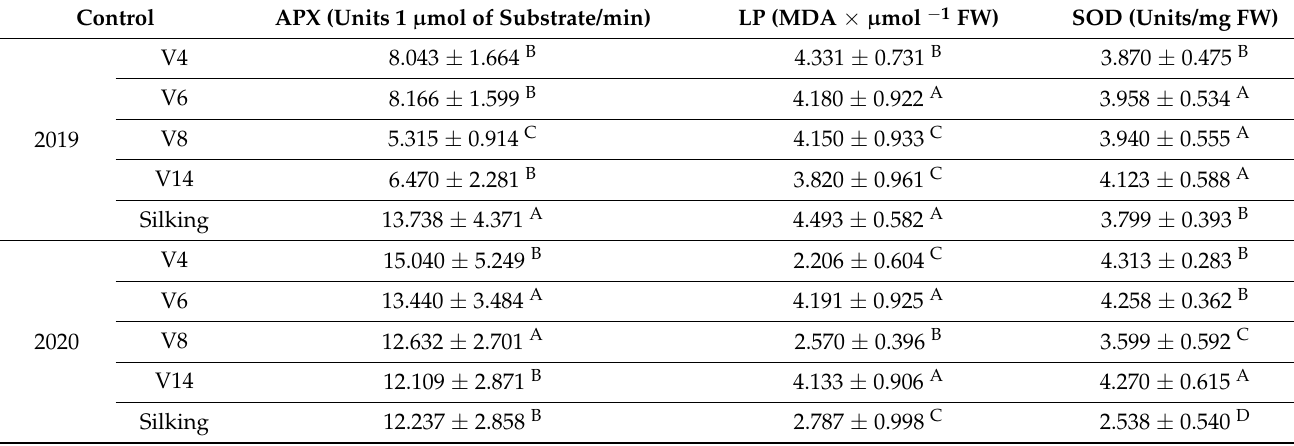
Table 1. Tukey pairwise comparisons the effect of the different sampling time and years for the APX: ascorbate peroxidase, SOD: superoxide dismutase activity, and the LP: lipid peroxidation under control condition. Treatments with the same letter are not significantly different.